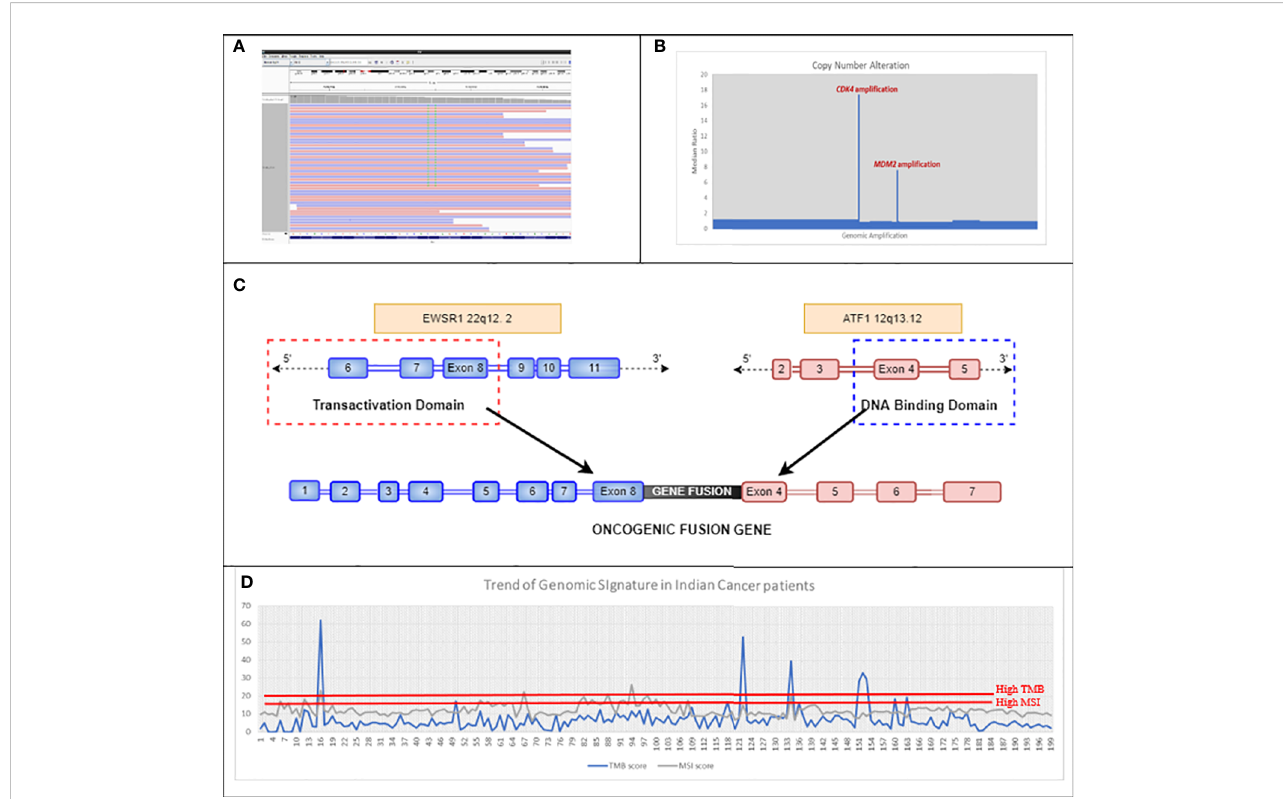
FIGURE 4 (A) Double mutation detected in exon 12 of KRAS , which led to an MNV change of KRAS G12F in Case 4BC-19. (B) Representative image of CNA detected using in-house bioinformatics pipeline, which showed ampli fi cation of CDK4 and MDM2 genes in Case number 4BC-63. (C) Schematic of the EWSR1 :: ATF1 fusion gene detected in case number 4BC-146. The EWSR1 :: ATF1 rearrangement is caused by the fusion of the N-terminal transactivation domain of EWSR1 gene with the C-terminal DNA binding domain of ATF1 gene. (D) Trend of mutational signatures (TMB and MSI) in 200 Indian cancer patients (unpublished 4baseCare data). The cutoff for MSI-H is >15 and that for TMB-H is >20. MNV, Muti-Nucleotide Variant; CNA, Copy Number Alteration; TMB, Tumor Mutational Burden; MSI, Microsatellite